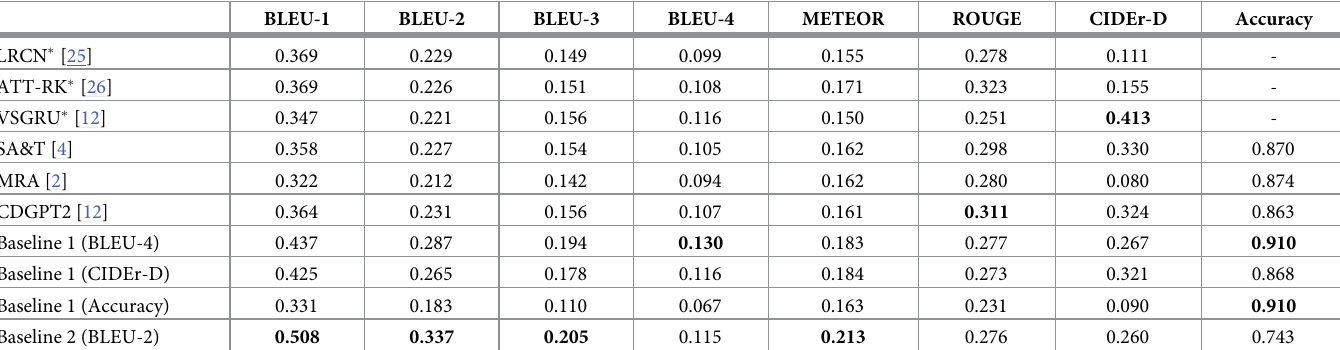
Table 2. Average performance results on the IU chest X-ray dataset over test